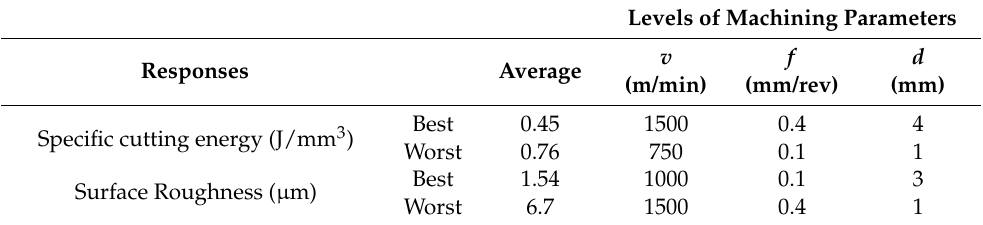
Figure 7. Main effect plot showing the influence of cutting parameters on Ra in TSM. Table 11. Results of confirmatory experiments for transitional speed machining.